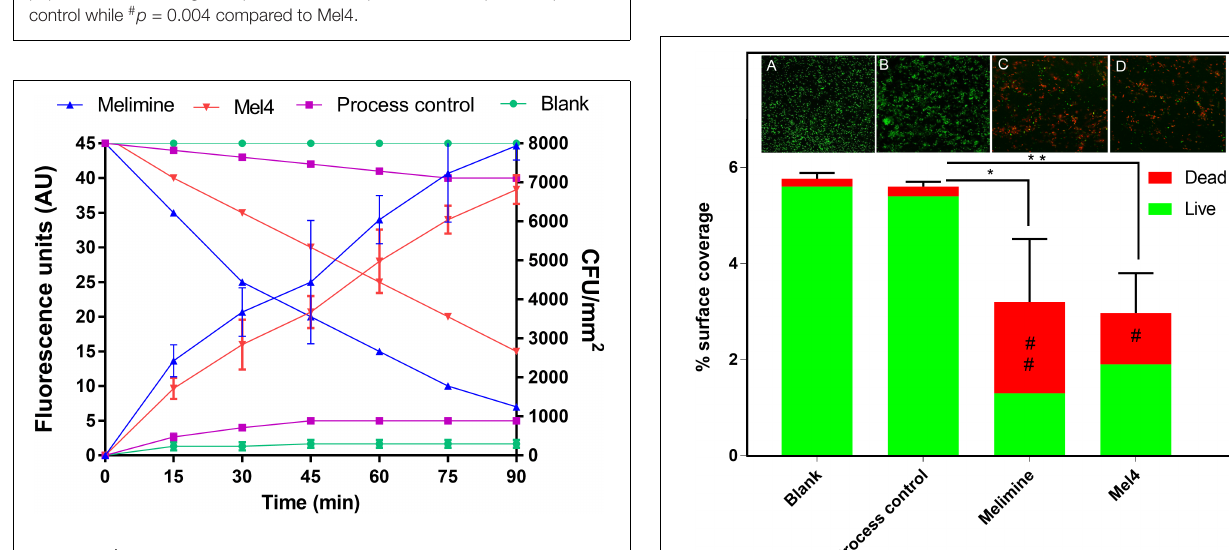
FIGURE 3 | Cell membrane depolarization. Cell membrane depolarization of P. aeruginosa 6294 as assessed by the release of the membrane potential sensitive dye DiSC3-5, measured spectroscopically at 622 nm excitation and 670 nm emission wavelengths, and corresponding bacterial cell death as determined by plate counts. Each symbol represents data curve for increase in fluorescence (on the left y axis) and for reduction in bacterial count CFU/mm 2 (on the right y axis). Data are presented as means ( ± SD) of three independent repeats performed in triplicate.